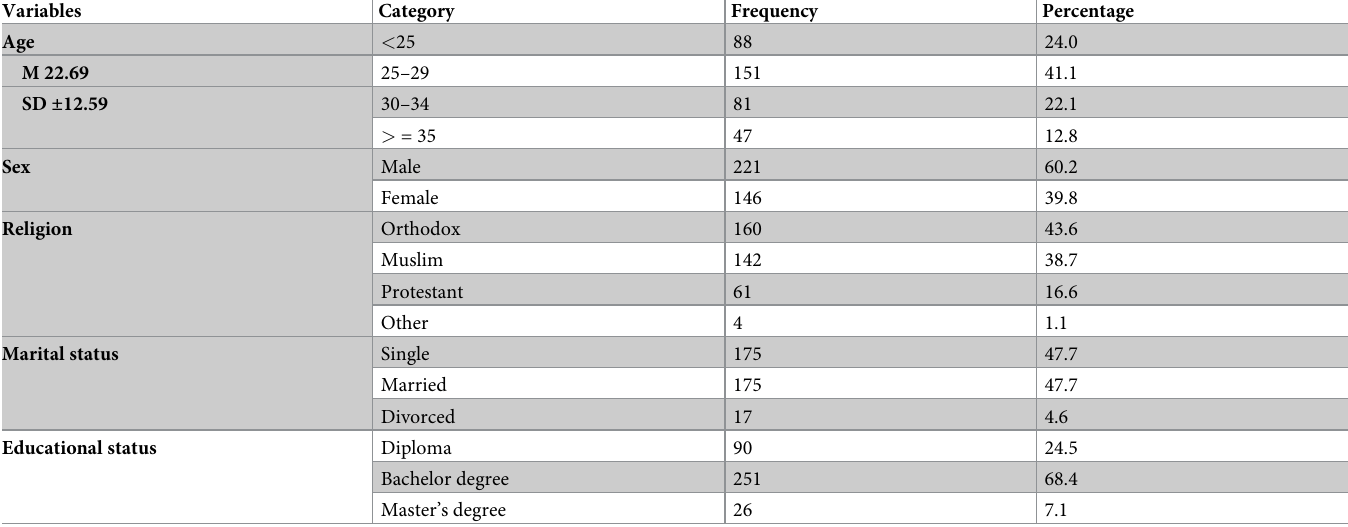
Table 1. Nurses’ socio-demographic characteristics at selected public hospitals in southwest Ethiopia in 2021 (n = 367).